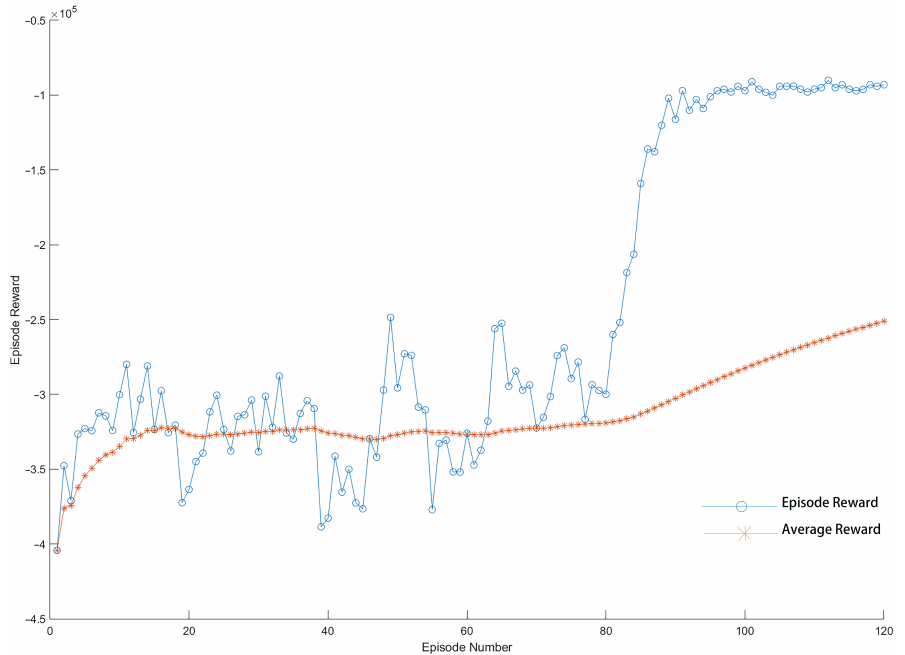
Figure 11. Number of